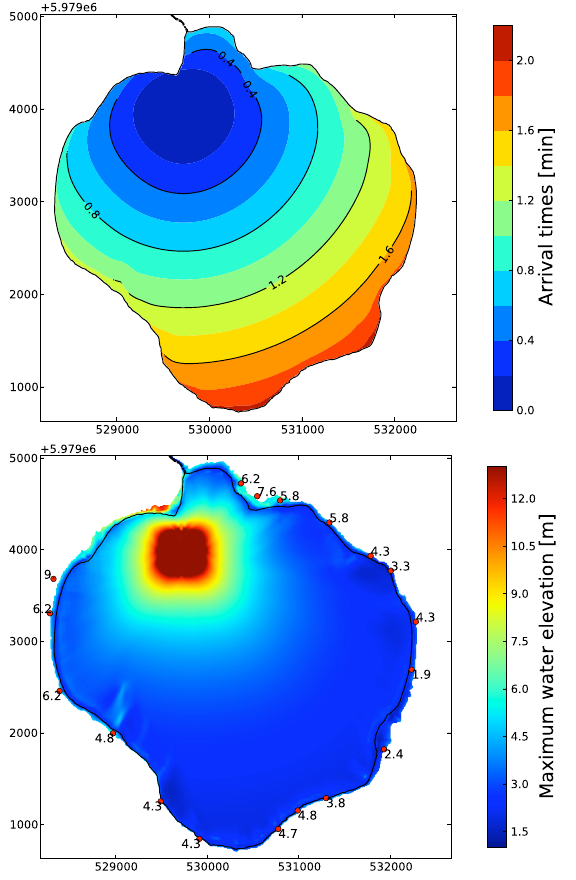
Fig. 3. Results of explosion simulation in Karymskoye lake with initial water crater rim η 0 = 55m. (Top) First wave travel times (in minutes). (Bottom) Maximum wave amplitude. Red points indicate positions of field measured run-up with the run-up values.